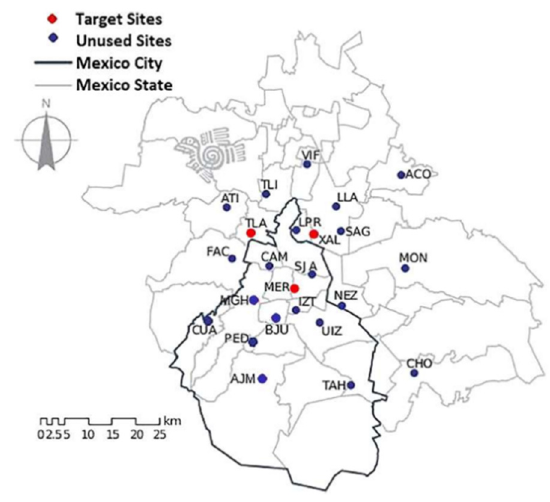
Figure 4. Map of the distribution of stations belonging to RAMA [41].